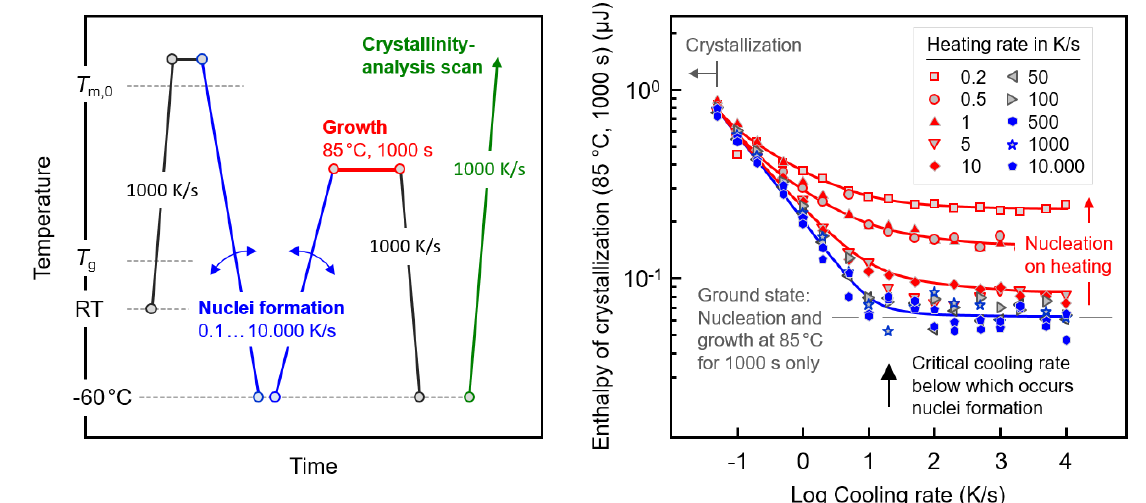
Figure 2. Temperature–time profile for the analysis of the cooling and heating rate dependencies of crystal nucleation of PBI ( left ); enthalpies of crystallization at 85 °C for 1000 s after subjecting the polymer to different cooling and heating histories ( right ). The lines serve to guide the eye only.